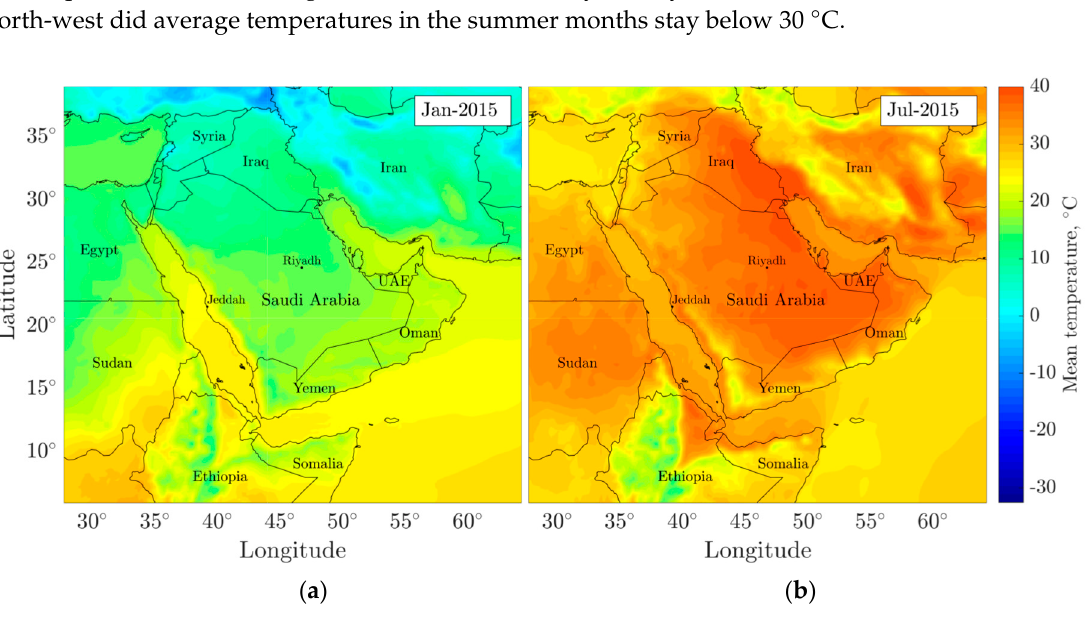
Table 1. Temperature characteristics of the most populated areas in each region for 2015 (°C). Mean